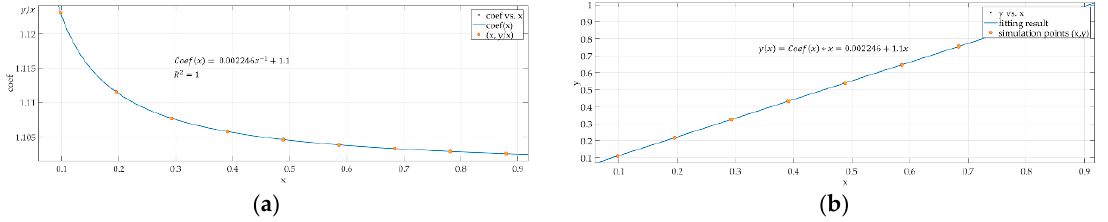
Figure 10. The result of fitting 10 points that are linear. ( a ) The coefficients obtained using the simulation points; ( b ) the fitting result (blue line).